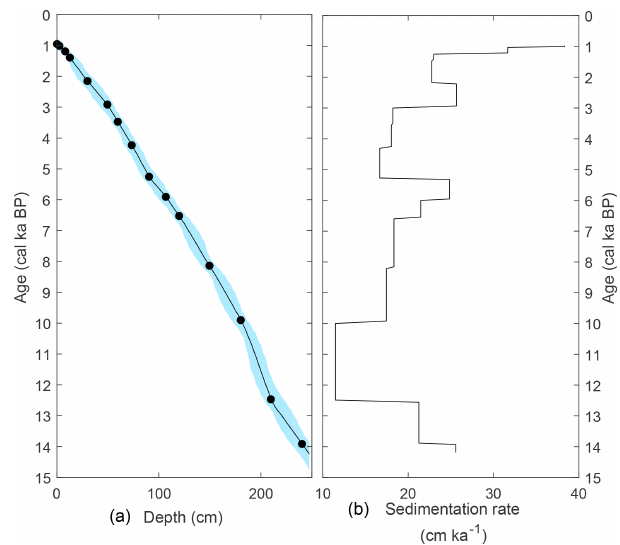
Figure 2. (a) Age–depth model for core COR1GC. The age model is constrained by 15 calibrated radiocarbon dates, the continuous line is the median age and shaded area represents the 95% con- fidence interval of the modelled core chronology. (b) Sedimenta- tion rate estimates for COR1GC based on median modelled ages for AMS 14 C